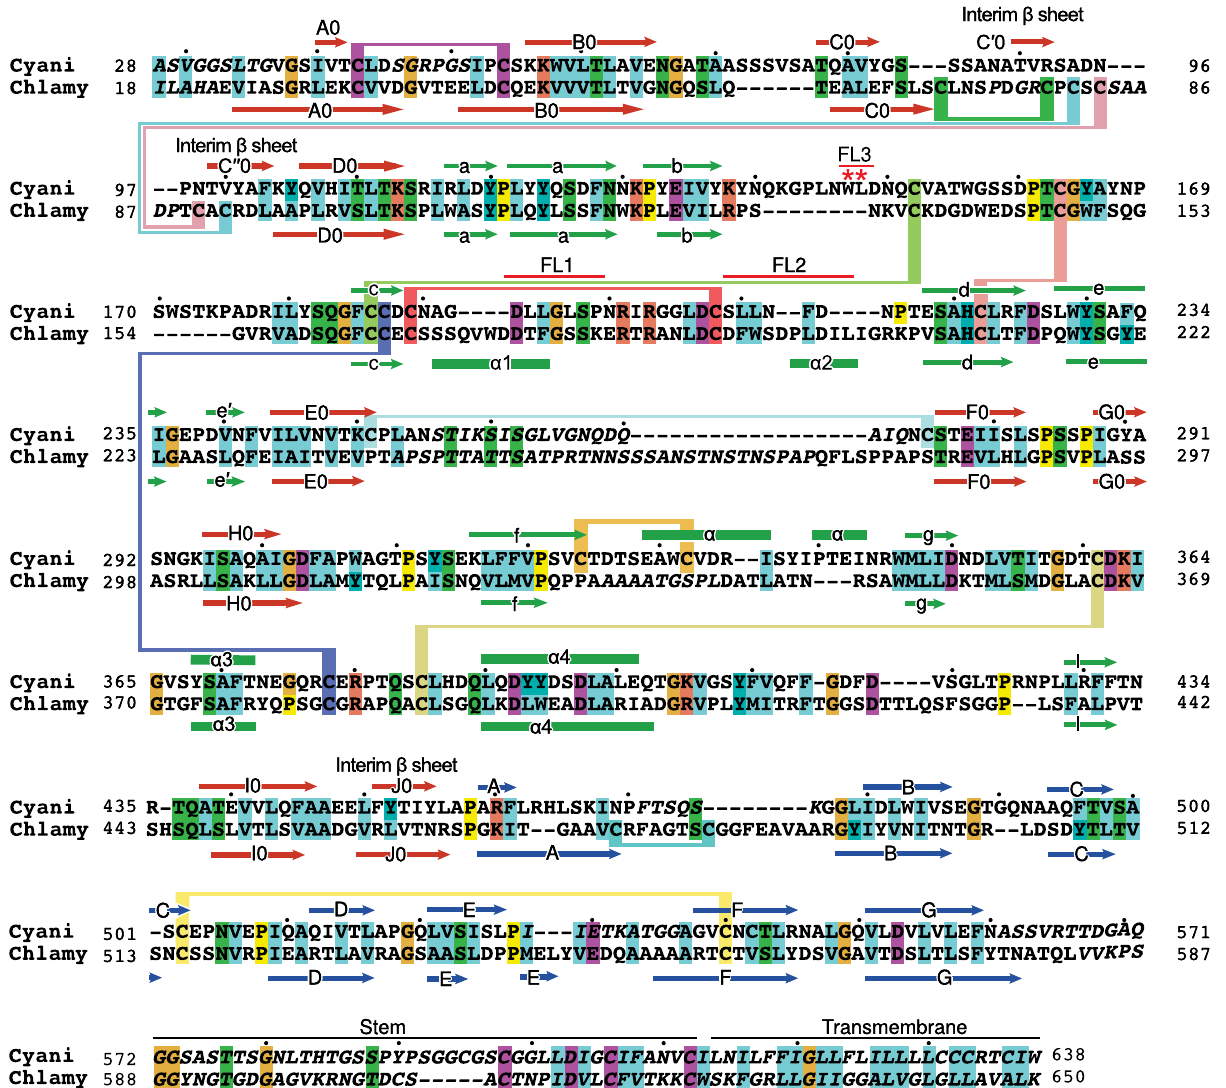
Fig. 3 Structure-based sequence alignment of Cyani and Chlamy HAP2. D1, D2, and D3 were individually structurally aligned with DeepAlign 23 . Gaps in poorly aligned regions were closed up using sequence homology. Residues not resolved structurally are in italics. Red asterisks mark putative fusion loop